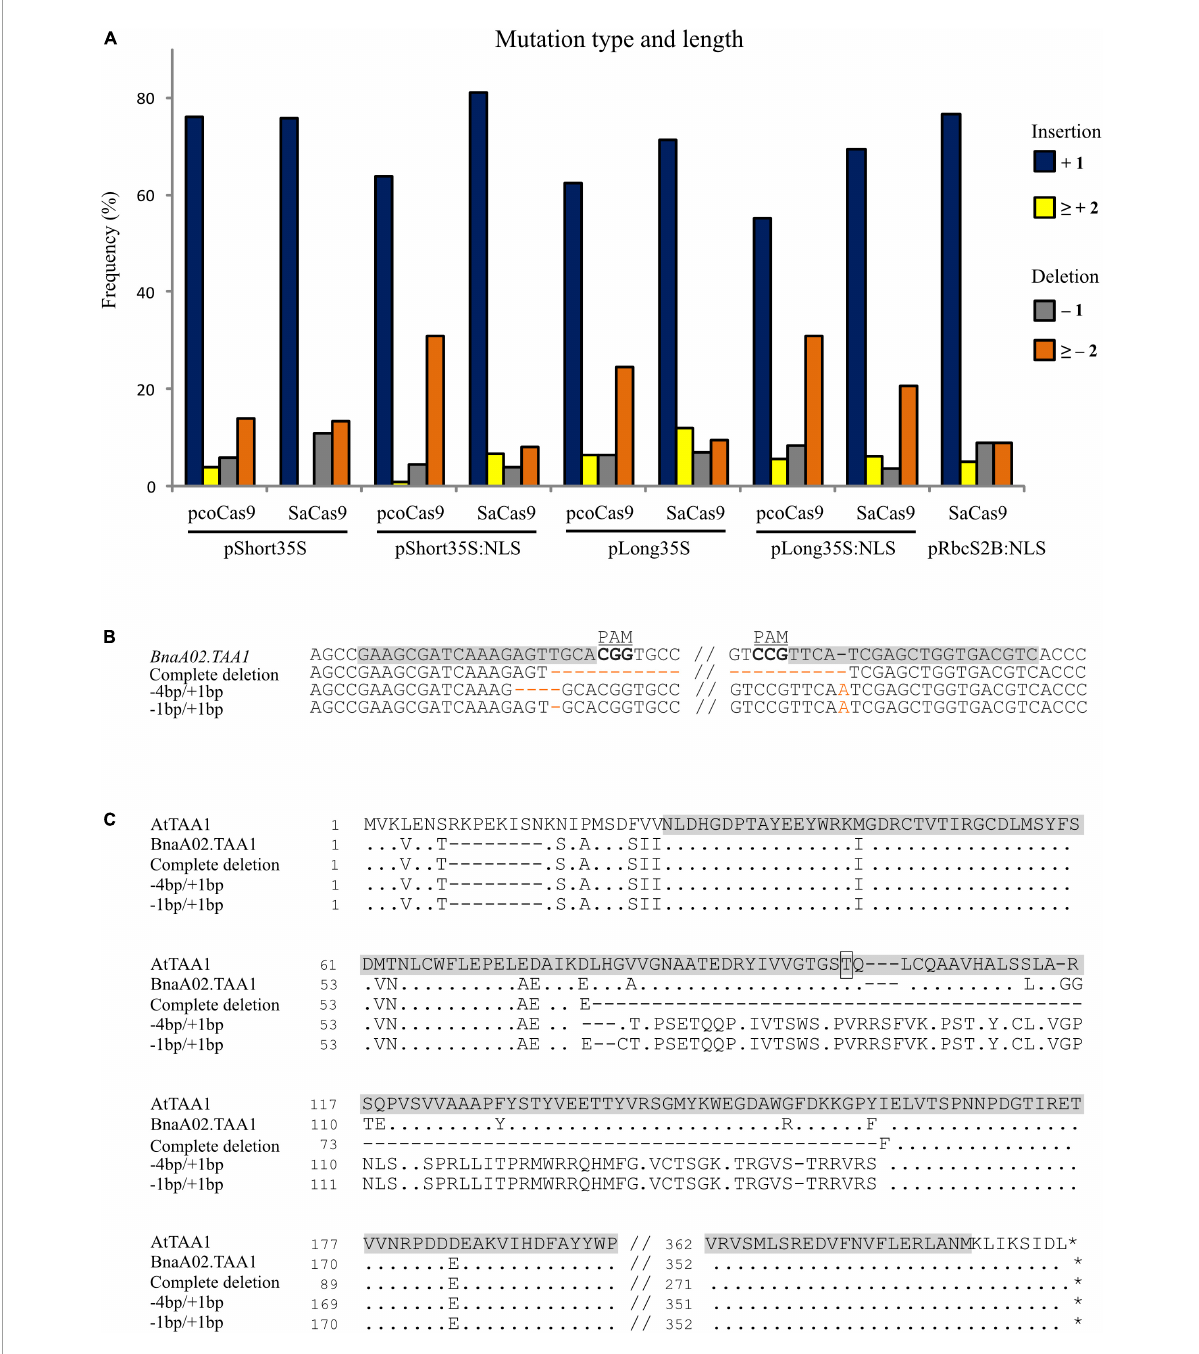
FIGURE3 Size of the indels and effects of large deletions. (A) Frequency of CRISPR/Cas9-induced mutations for each construct in relation to the size of the indel: insertion of one base (dark blue), insertion of 2 or more bases (yellow), deletion of 1 base (gray), and deletion of two or more bases (orange). The frequency is calculated as the number of mutated loci in the given category over the total mutated loci with the analyzed construct. (B) Mutations in BnaA02.TAA1 induced by pcoCas9 constructs detected in hairy root lines compared to the wild-type sequence. The gRNA target site is highlighted in gray, the PAM sequence is bolded. The complete deletion of the sequence between the two gRNA loci and specific combinations of mutations at exon II and exon III (4 or 1-base deletion with 1-base insertion) are indicated in orange color. (C) Protein sequence alignment of TAA1. Comparison of A. thaliana ortholog (AtTAA1) with wild-type allele of BnaA02.TAA1 and deduced amino acids from CRISPR/Cas9 mutants with a sequence deletion between the two guides loci or two specific combinations of mutations (–4/ + 1, –1/ + 1) enabling ORF restoration. Dots and dashes represent identical and deleted nucleotides, respectively. The alliinase domain in AtTAA1 is highlighted in gray, and the phosphorylation site at T101 is